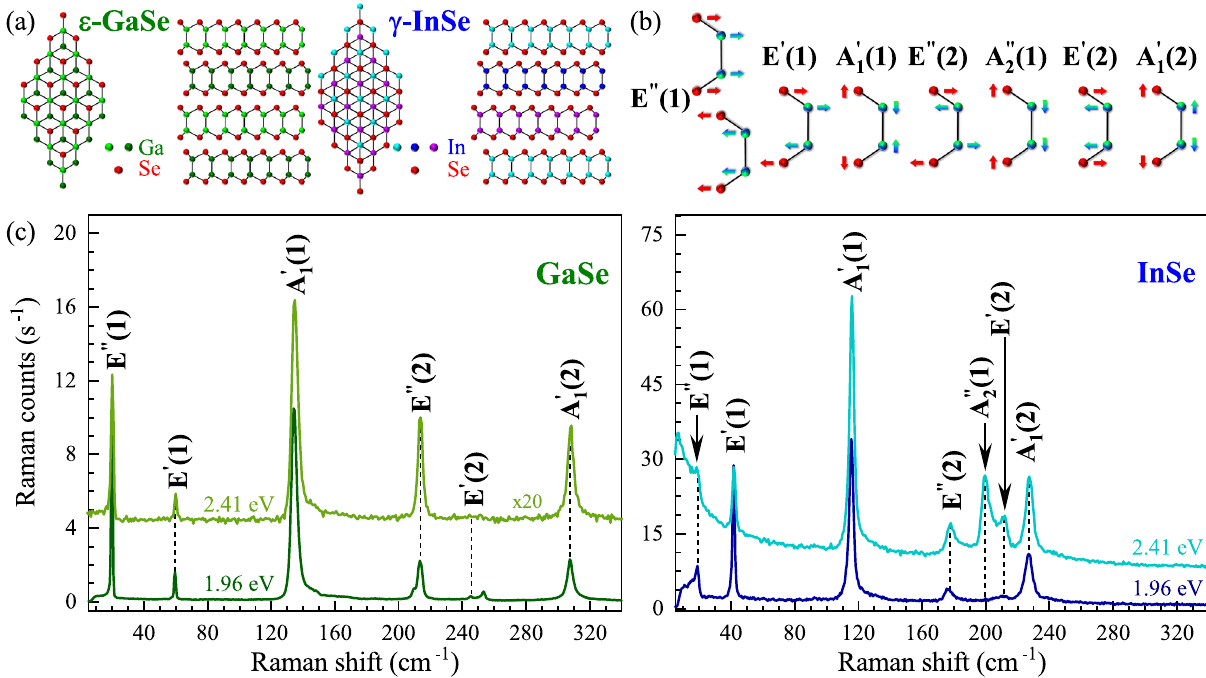
Figure 1. ( a ) Atomic structure and stacking order of ε -GaSe and γ -InSe. ( b ) Atomic displacements of the studied phonon modes. ( c ) unpolarized Raman scattering spectra of the GaSe (green/bright green) and InSe (blue/bright blue) crystals measured under two different excitation energies at room temperature. The spectra are shifted for